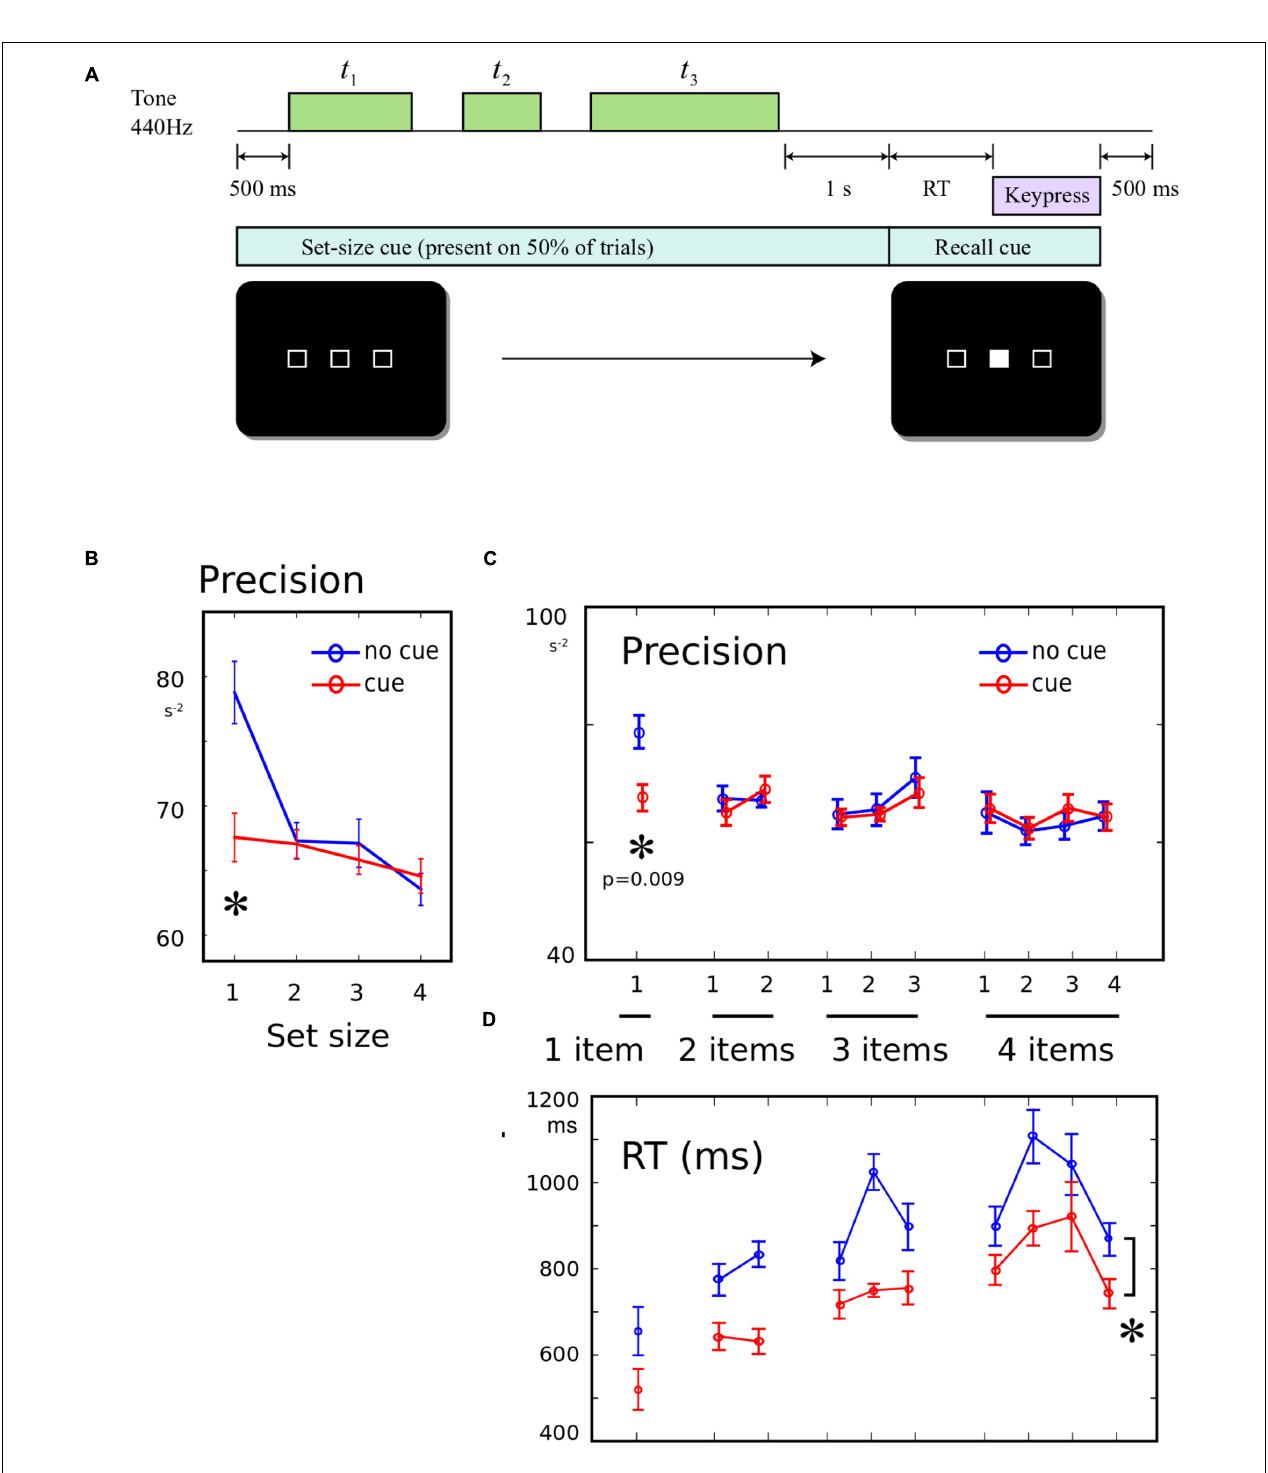
FIGURE 3 | (A) Informing participants about the number of upcoming tones: 500 ms prior to the start of each trial, a screen was presented. On half the trials, this screen comprised a row of empty boxes, with the number of boxes corresponding to the number of tones that will be presented on this trial. The cue remained on-screen until the recall cue. On the remainder of trials, a cross was displayed instead, giving no information about the number of tones. (B) Precision for a single memory item was worse when number of items is known: The recall precision was significantly lower when a single tone was presented, if it was expected that the tone would be single, compared to when it was unexpectedly single. (C) No effect of pre-cueing set-size on other conditions: There was no worsening or improvement in recall when the number of items was known in advance, and there was no change in the shape of the serial position curve. (D) Response times faster when set-size was known in advance: On cued trials, RT was significantly shorter (main effect of cue). This did not interact with serial position.